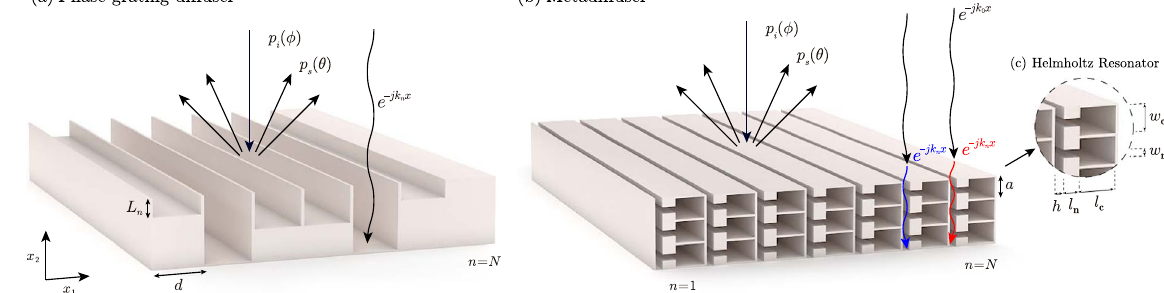
Figure 1. ( a ) Scheme of a QRD Schroeder diffuser composed by N = 7 wells or quarter wavelength resonators. ( b ) Metadiffuser composed of N = 7 sub-wavelength slits, each of them loaded by M = 3 Helmholtz resonators, with slightly different geometry. ( c ) Detail of a slit of the metadiffuser showing the geometrical parameters of the cavity of a HR ( w c and l c ) and its neck ( w n and l n